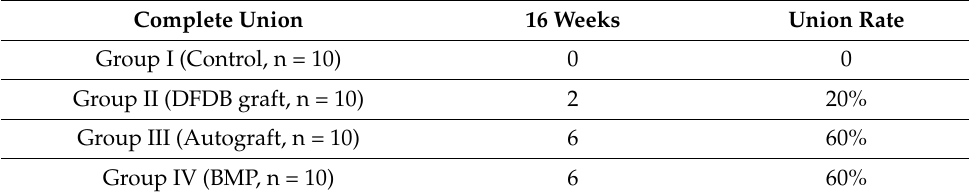
Table 2. Manual test. Manual palpation with varus/valgus and anterior/posterior angulated force was performed for all harvest femora (16 weak after surgical procedure). When no motion was present, it was considered a complete union. (one-way ANOVA, p < 0.05. Posthoc test with Scheffe, group I vs. group II p = 0.072; group I vs. group III, p < 0.001; group I vs. group IV, p < 0.001; group II vs. group III, p = 0.018; group II vs. group IV, p = 0.018; group III vs. group IV, p =